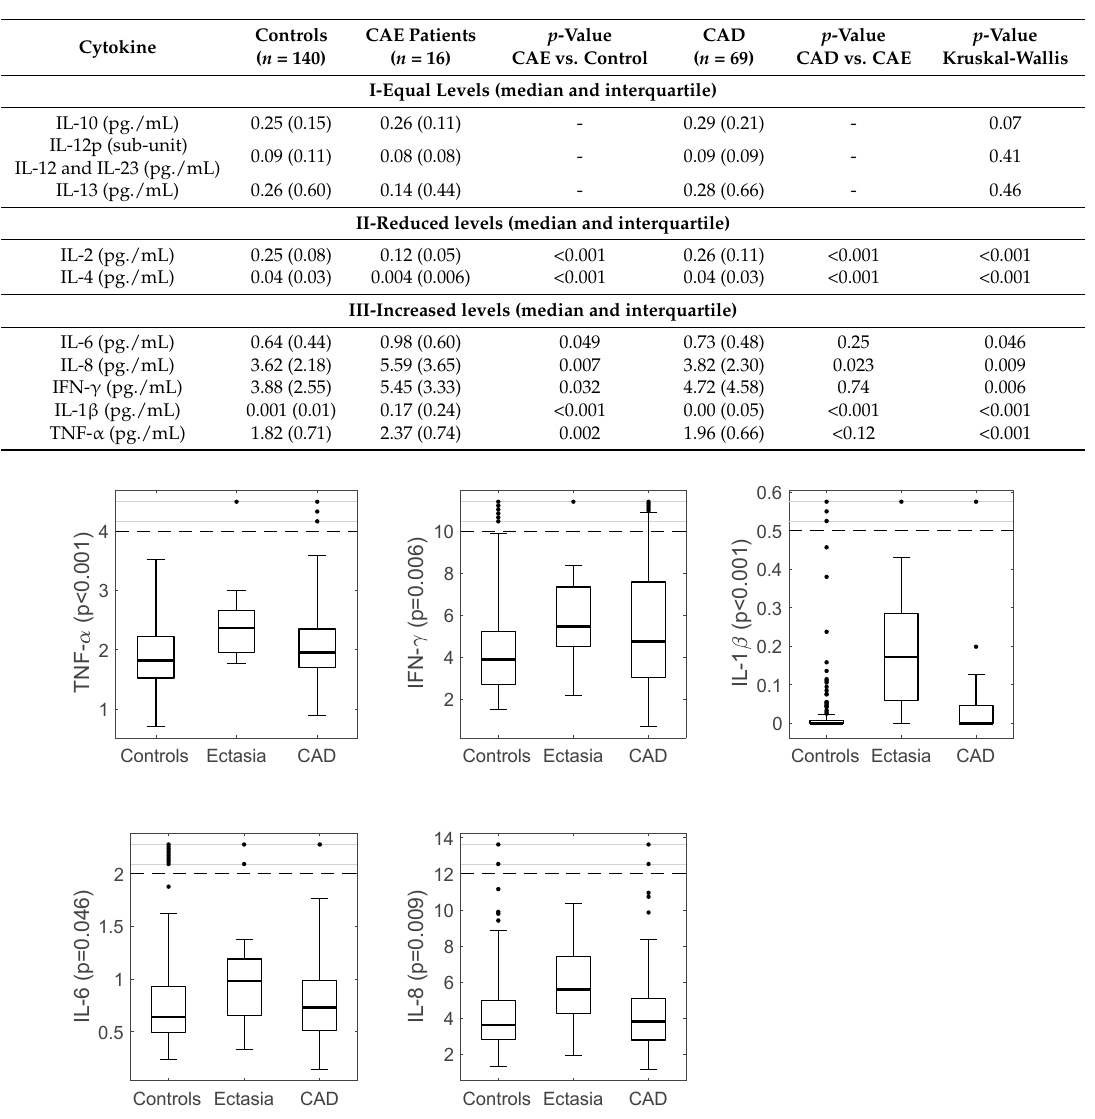
Figure 1. Cytokines with significantly higher levels in CAE patients compared to controls. P -values are derived from Kruskal–Wallis test of all three groups (see Table 2). CAE patients also presented with significantly higher levels IL-1 β and IL-8 than CAD patients. Boxes show median and interquartile. Dashed lines indicate the threshold for defining extreme values, which are shown in a compressed region between the solid lines.